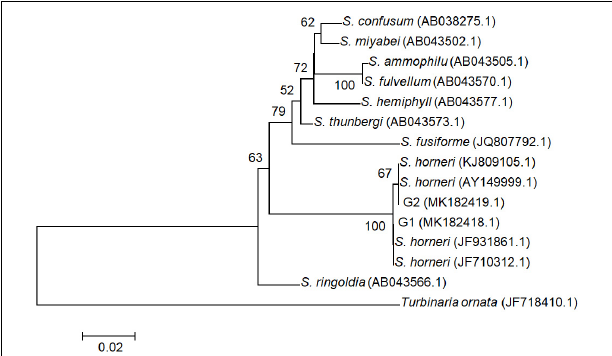
FIGURE 3 | Phylogenetic NJ tree based on ITS2 alignment. Numbers at internal nodes indicate support values obtained using the bootstrap method with NJ. Scale indicates substitutions per site. G1 and G2 represented two genotypes of ITS2 sequences in S. horneri , representing intra-individual polymorphism in both yellow and brown samples.